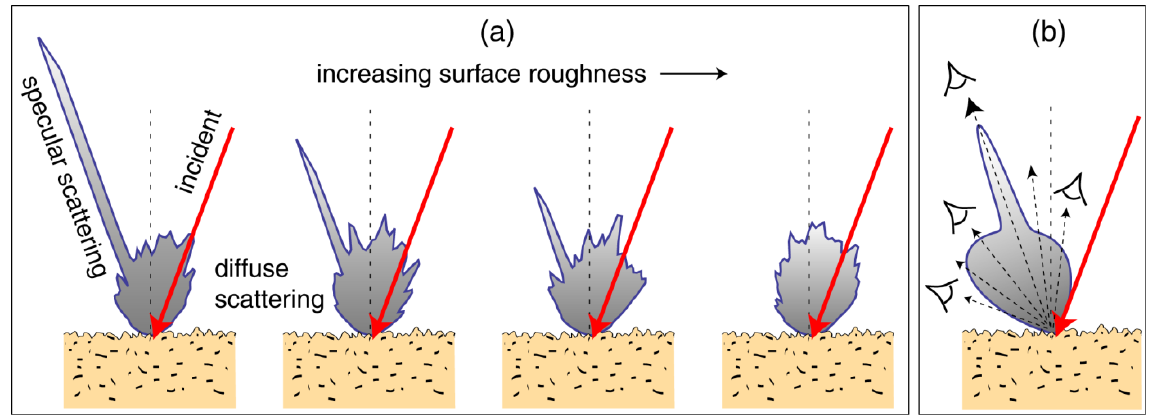
Figure 10. (a) FDTD calculation of scattered light from a random surface with roughness increasing from left to right. (b) A phenomenological Cook-Torrance scattering